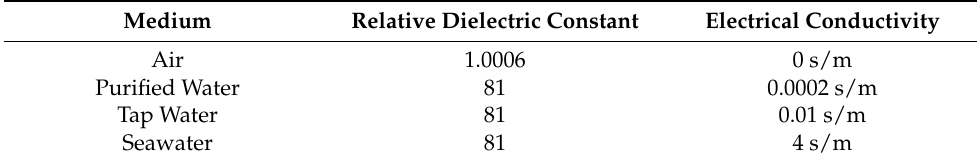
Table 5. Conductivity and dielectric constants of several gap media. Medium Relative Dielectric Constant Electrical